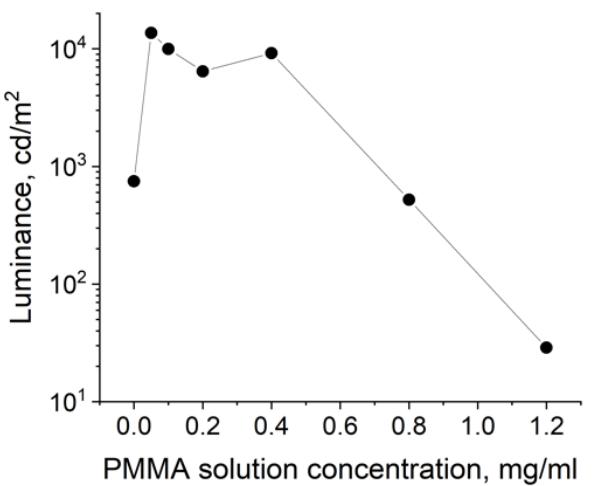
Table 1. Summary of the performance parameters of the fabricated QDLED devices with and without a PMMA layer deposited from PMMA solutions with different concentrations.